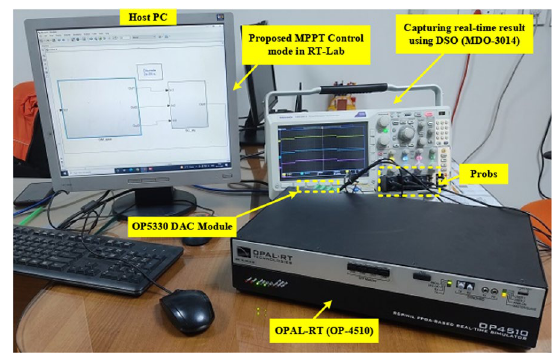
Fig. 24 Laboratory based experimental radiation and temperature levels. As seen, low-oscilla- tion tracking of the MPP is achieved using the proposed control approach. In addition, the MPP is accurately monitored despite a sudden increase in radiation from 500 to 1000 W/m 2 and an increase in temperature from 25 to 35 °C.